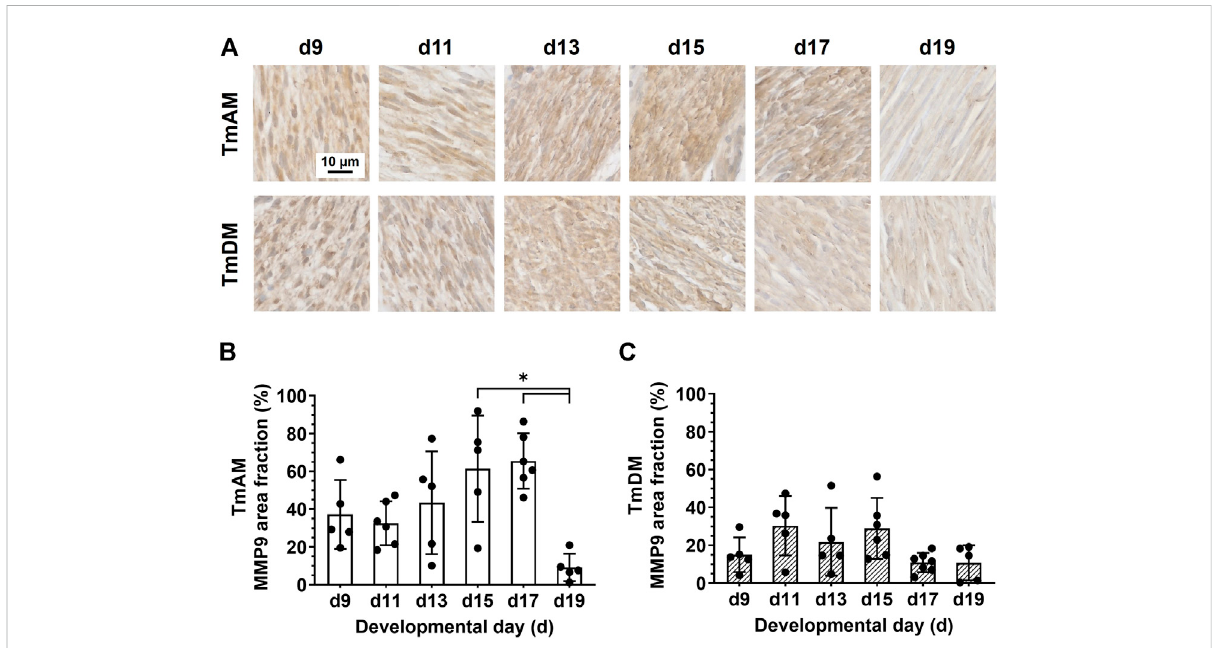
FIGURE 10 MMP9 was present in jaw-closing TmAM and jaw-opening TmDM between d9 and d19. (A) Representative bright fi eld images of MMP9 IHC of TmAM andTmDM. (B) InTmAM,percentageareafractionpositivefor MMP9decreasedsigni fi cantlyafter d17. (C) InTmDM,percentageareafraction positive for MMP9 remained relatively constant between d9 and